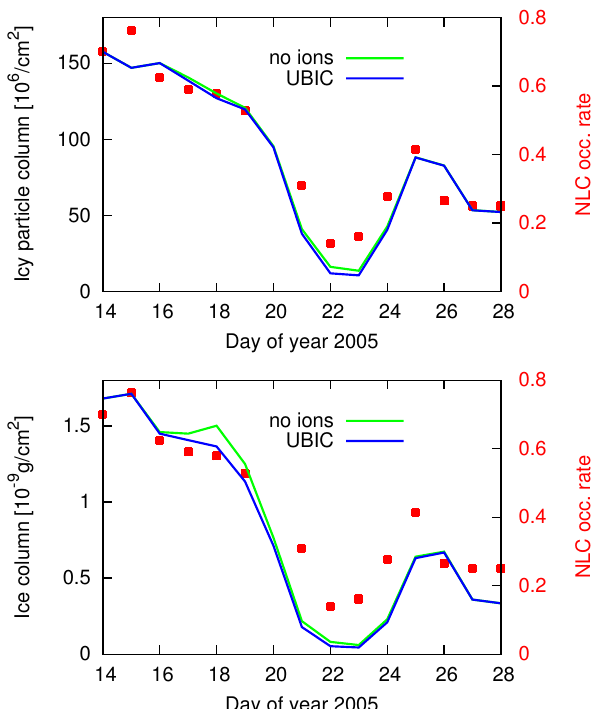
Fig. 16. Upper panel: total column of icy particles in units of 10 6 cm − 2 for (green) simulation without ion chemistry, and (blue) simulation including the ion chemistry model (UBIC) at 75 ◦ S as well as (red dots) the SCIAMACHY daily mean NLC occurrence rate (70–80 ◦ S). Lower panel: as the upper one but showing the to- tal ice column in units of 10 − 9 gcm − 2